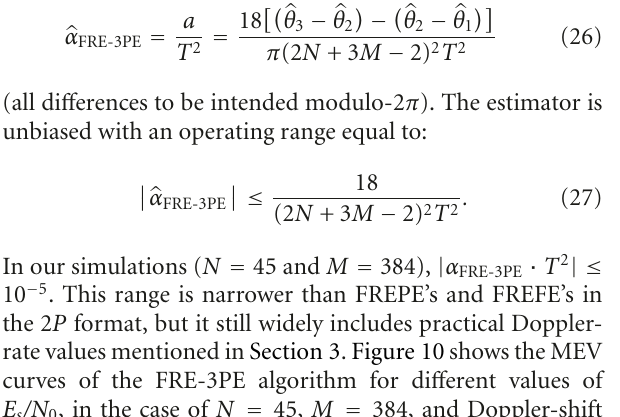
Figure 8: MEV of FREFE estimator for di ff erent values of the Doppler-shift vT —simulation only. FREFE estimator preamble + postamble Luise and Reggiannini, N = 44, M = 385, E s /N 0 = 10 dB.